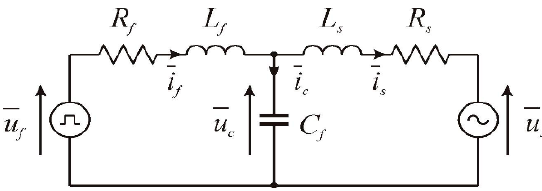
Figure 6. Equivalent LCL coupling filter